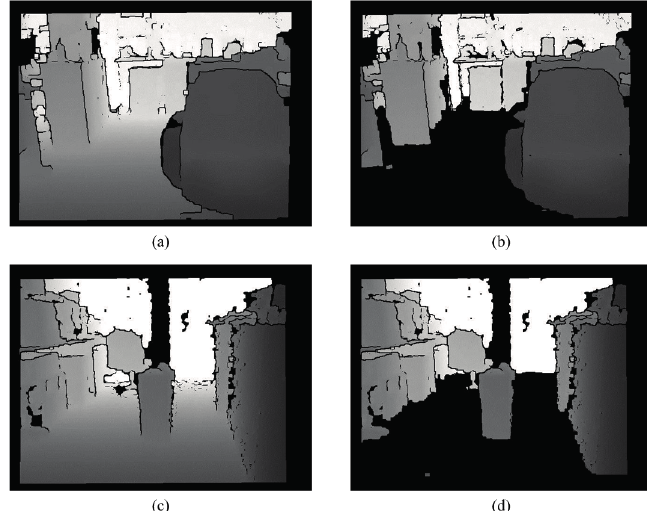
Figure 14. Removal of the ground. ( a ) Edge removed image 1; ( b ) Processing result of ( a ); ( c ) Edge removed image 2; ( d ) Processing result of ( c ).